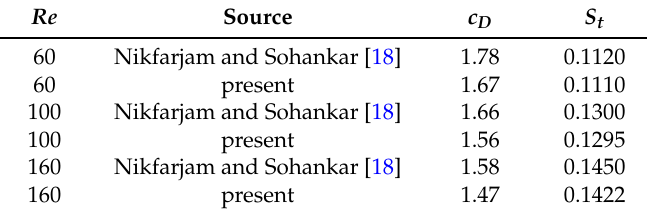
Table 2. Comparison of drag coefficients and Strouhal numbers for n = 1.4 and different Reynolds numbers.